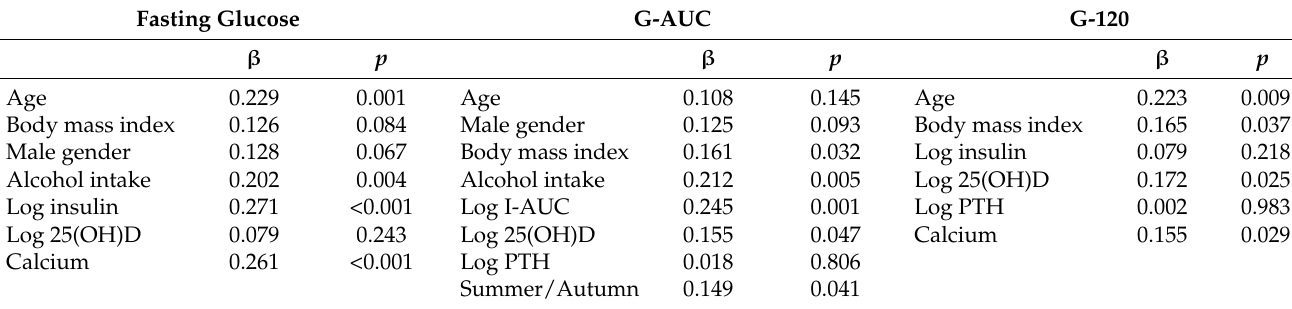
Table 5. Multivariate analysis with fasting glucose, G-AUC, and G-120 as dependent